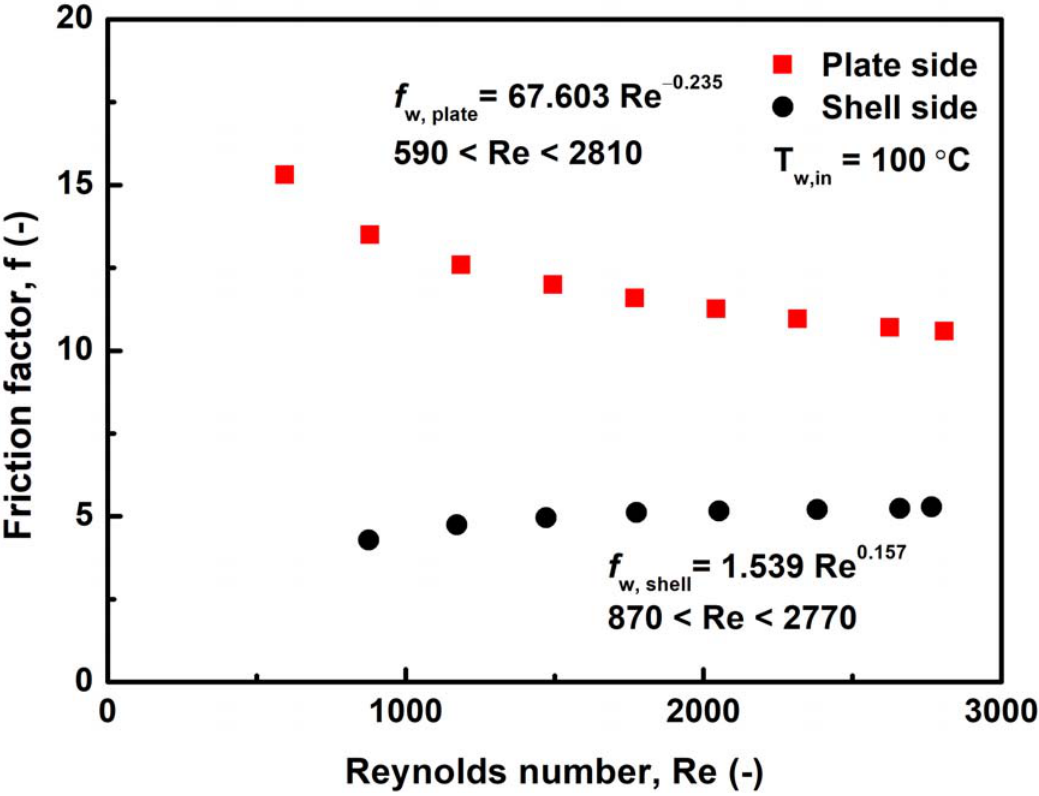
Figure 10. The f on the plate and shell sides with respect to the Re in PSHE. A correlation of the f for water can be expressed as a function of Re, as shown in Equation (20). Finally, the coefficient b and exponent z of Re on the plate and shell sides of the PSHE were determined based on the measured data, as shown in Equations (21) and (22), respectively.